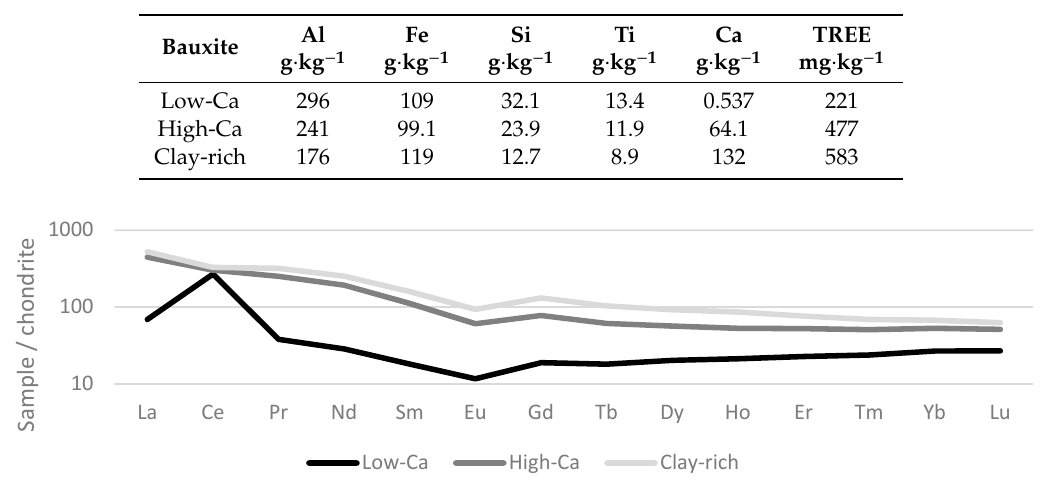
Figure 2. Chondrite normalised [44] pattern of REE elements for each of the bauxites tested. Table 5. REE-bearing phases present in the bauxite samples used in this study, identified from thin